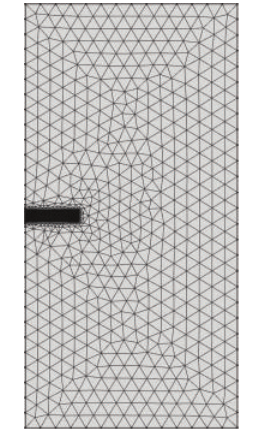
Figure 7: Cracking contour.